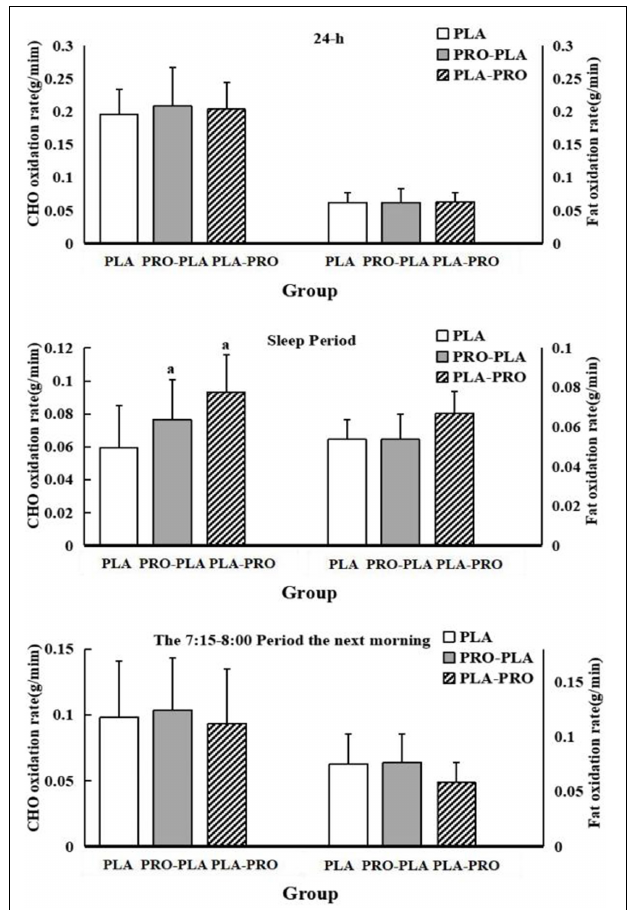
FIGURE 4 | Carbohydrate (CHO) and fat oxidation rates within 24 h, during sleep, and during the basal metabolic period in PLA, PRO-PLA, and PLA-PRO (unit: g/min). a p < 0.05 PLA-PRO, PRO-PLA VS PLA, adjusted for age, sex, %fat, relative VO 2max , sleep quality, the time of sedentary behavior and moderate and vigorous intensity physical activity in the pre-experiment stage, resistance energy expenditure under each condition (model 1); additionally adjusted for 24-h total energy intake based on model 1 (model